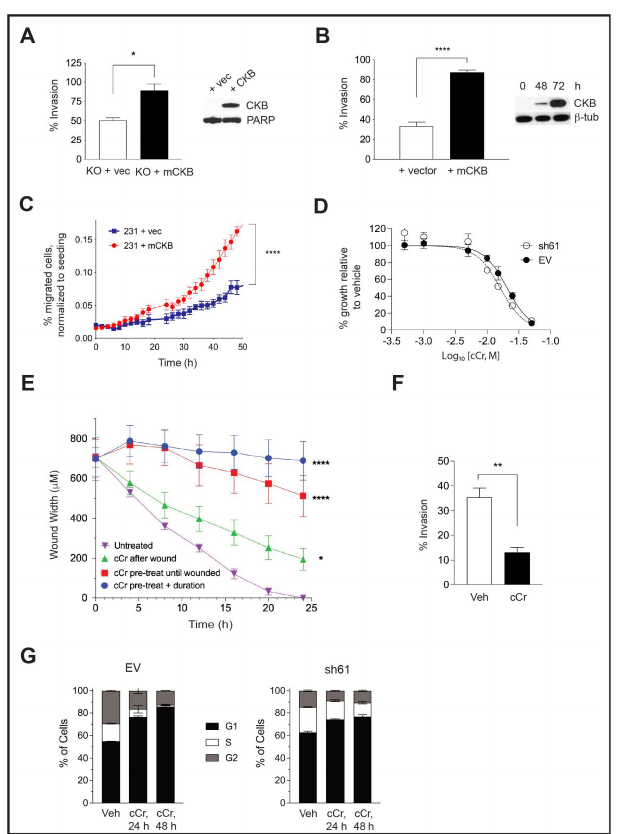
Figure 4. Ectopic expression of CKB in HIF-1 KO PyMT cells or in human MDA-MB-231 TNBC cells enhances cell invasion, but cCr treatment represses wound healing, invasion, and cell cycle progres- sion. ( A ) The percentage of invading cells was compared between PyMT HIF-1 KO + vector control (+vec) and PyMT HIF-1 KO + mCKB (+CKB) cells over three biological experiments; the overall mean ± SEM is shown. The insert shows CKB expression by Western blotting relative to total PARP (loading control). ( B ) The percentage of invading cells in MDA-MB-231 TNBC cells transfected with vector alone (+vector) or with mCKB (+mCKB); cells were plated for invasion assays 72 h post-trans- fection, when CKB levels were maximally expressed (Western blot insert, β -tubulin as a loading